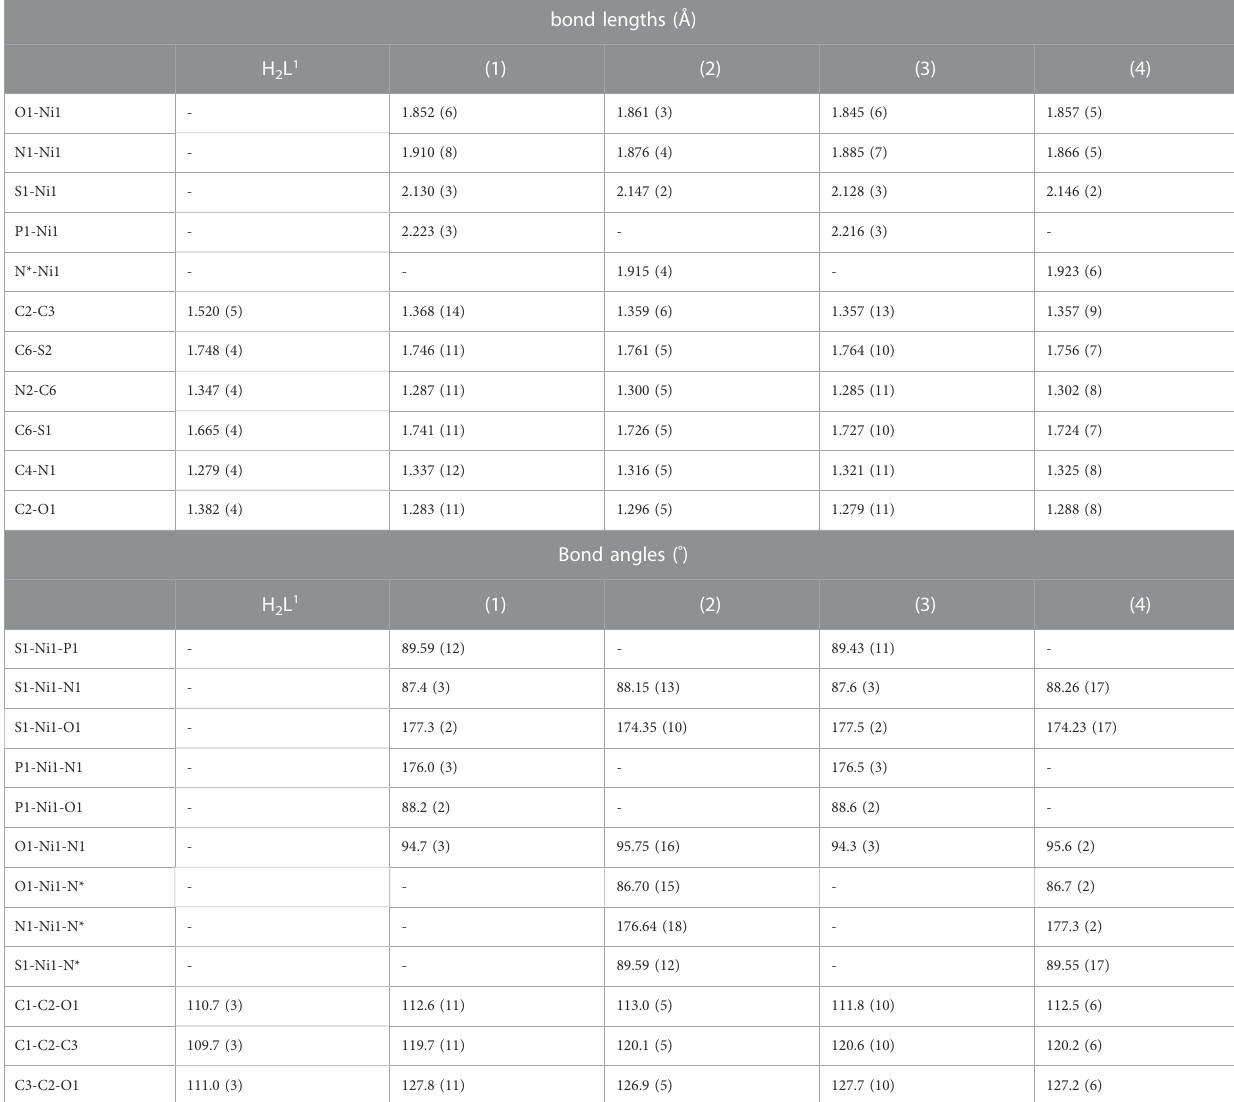
TABLE 2 Selected bond lengths (Å) and angles ( ° ) for H 2 L 1 and the complexes (1 –